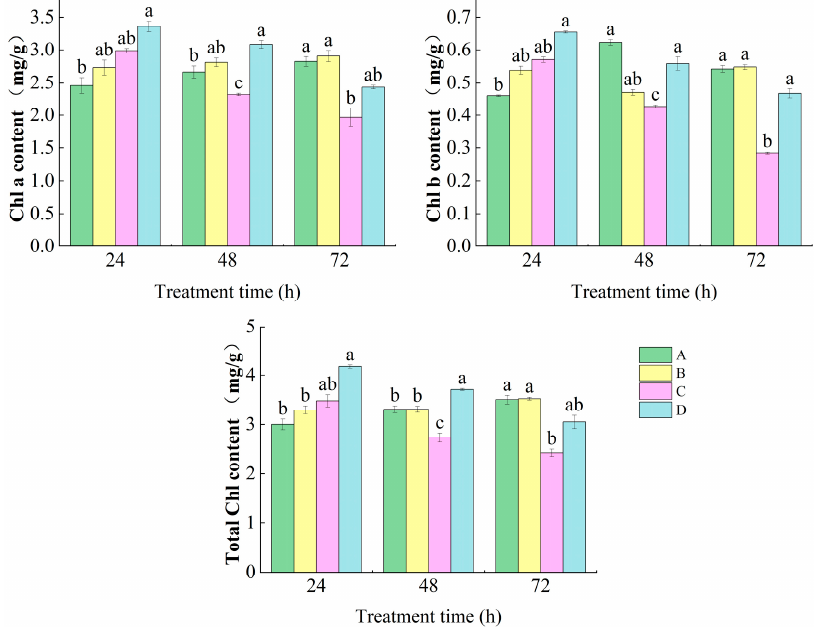
Figure 1. Effect of exogenous ALA on chlorophyll content of wild jujube seedlings under NaCl stress. Note: Different lowercase letters indicate significant differences between treatments at the level of p < 0.05, attested using LSD and Duncan’s method test. Error bars represent SD (n = 3).